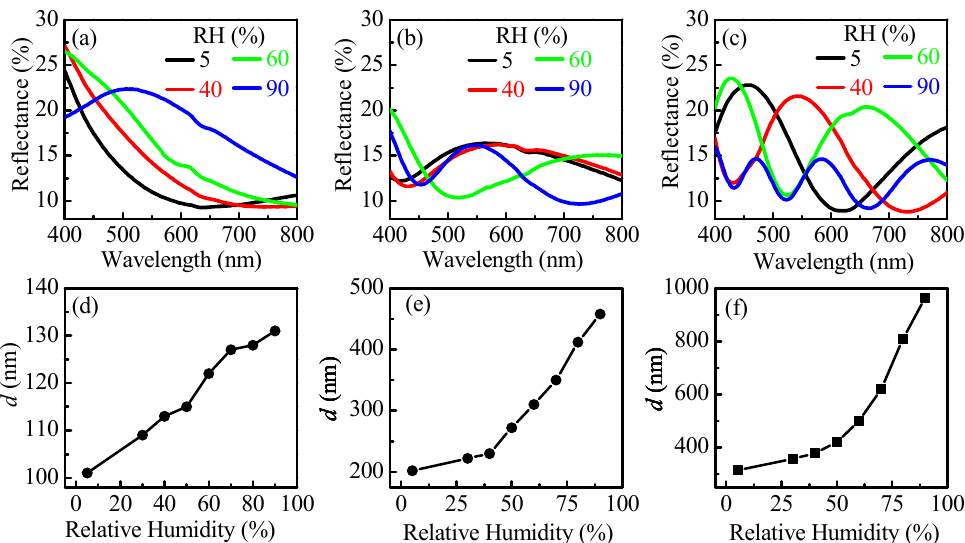
Figure 3. Reflectance spectra at denoted relative humidity values of thin polymer films with thickness of 100 nm ( a ), 200 nm ( b ), and 300 nm ( c ) deposited on silicon substrates. Growth of film thickness with relative humidity for thin polymer films with initial thicknesses of 100 nm ( d ), 200 nm ( e ), and 300 nm ( f